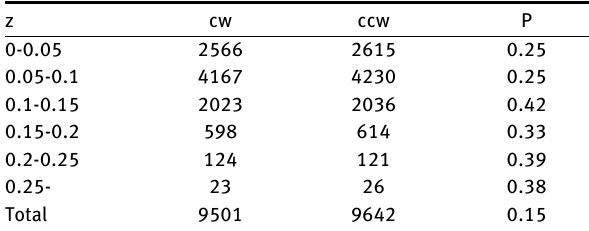
Table 13. The distribution of clockwise and counterclockwise galax- ies in different z ranges in the RA range (120 ∘ , 210 ∘ ). The P value is the binomial probability of having equal or higher asymmetry between the number of clockwise and counterclockwise galaxies in each redshift range.